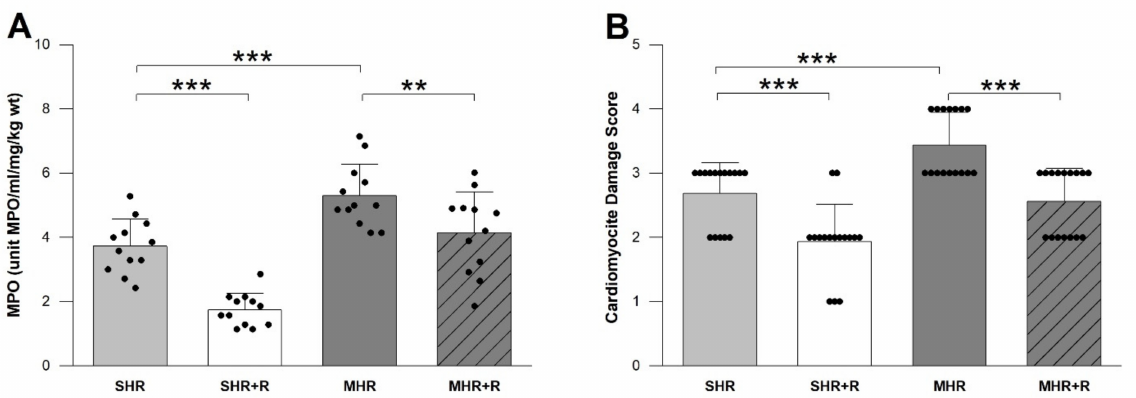
Figure 4. MPO-myeloperoxidase enzyme activity ( A ) and CDS-Cardiomyocyte Damage Score ( B ) in experimental groups. SHR- spontaneously hypertensive rat; SHR + R-spontaneously hypertensive treated with resveratrol; MHR-malignant hypertensive rat; MHR + Rmalignant hypertensive rat treated with resveratrol. Values are means ± SD. *** indicate p < 0.001, ** p <